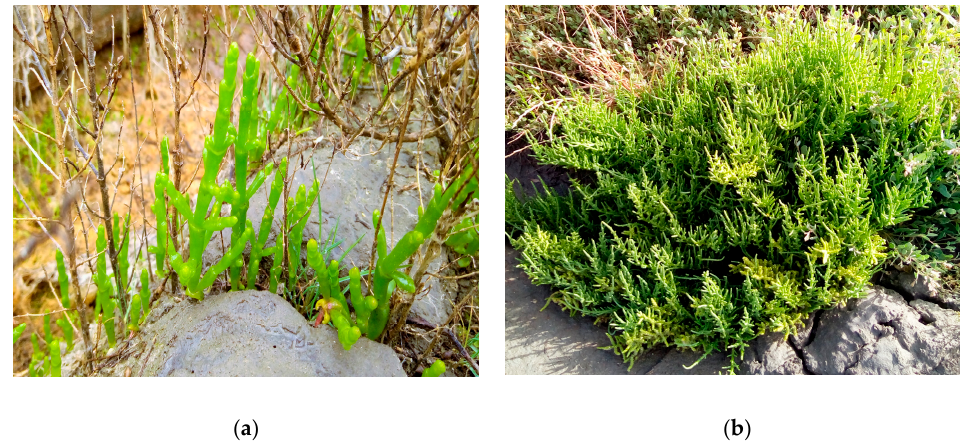
Figure 1. Overview of the halophytes studied. ( a ) Salicornia ramosissima (July); ( b ) Sarcocormia perennis alpini (July).